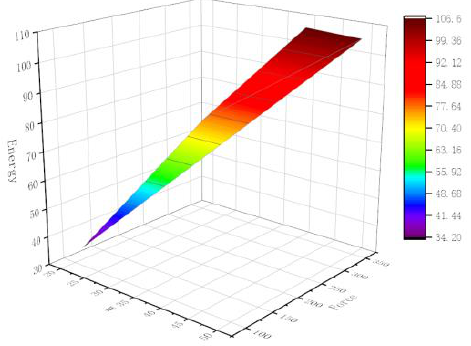
Figure 10. Three-dimensional figure of D – energy – force.